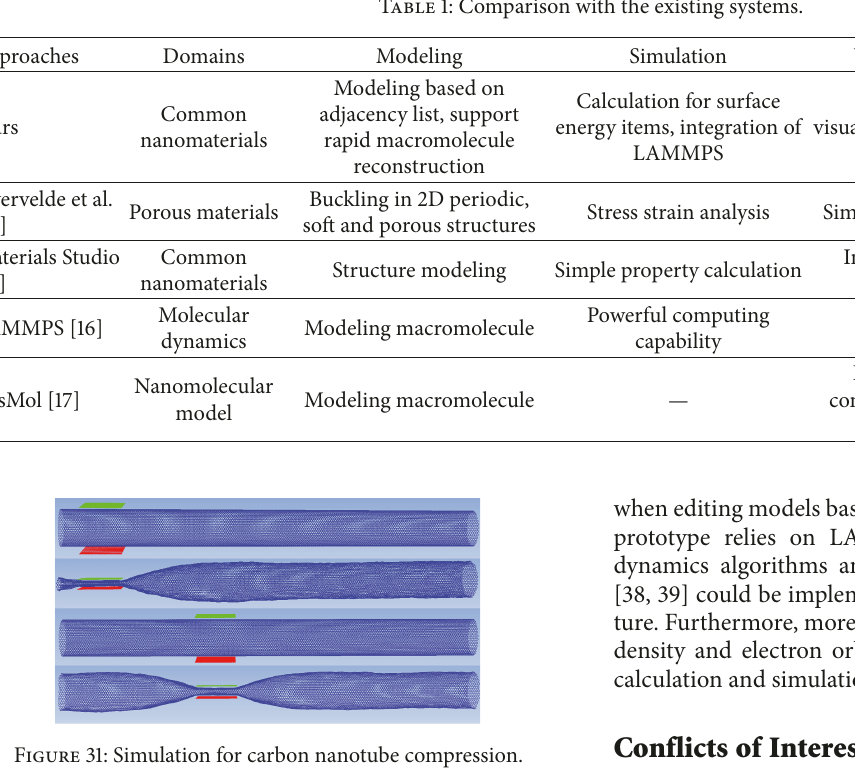
graphene, carbon nanotube, and MOFs, which is supposed to be convenient and